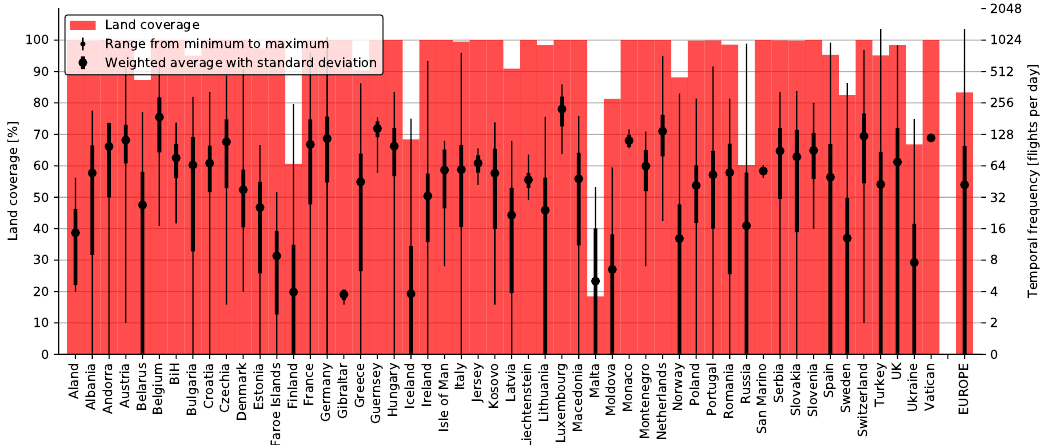
Figure 14. Temporal frequency (number of flyovers in a single day) for all flights using Imperx T9040. A similar study was performed for individual alliances, namely OneWorld, SkyTeam, and Star Alliance for the entirety of Europe. Figure 15 depicts basic statistics for each alliance with 3.45, 4.65, and 5.56 average daily flyovers, respectively. The graph also shows that higher coverage and temporal frequency for alliances gave higher deviation as flights were more scattered around Europe. This is also visible in Figure 15a–c, depicting temporal heat maps for all three alliances,